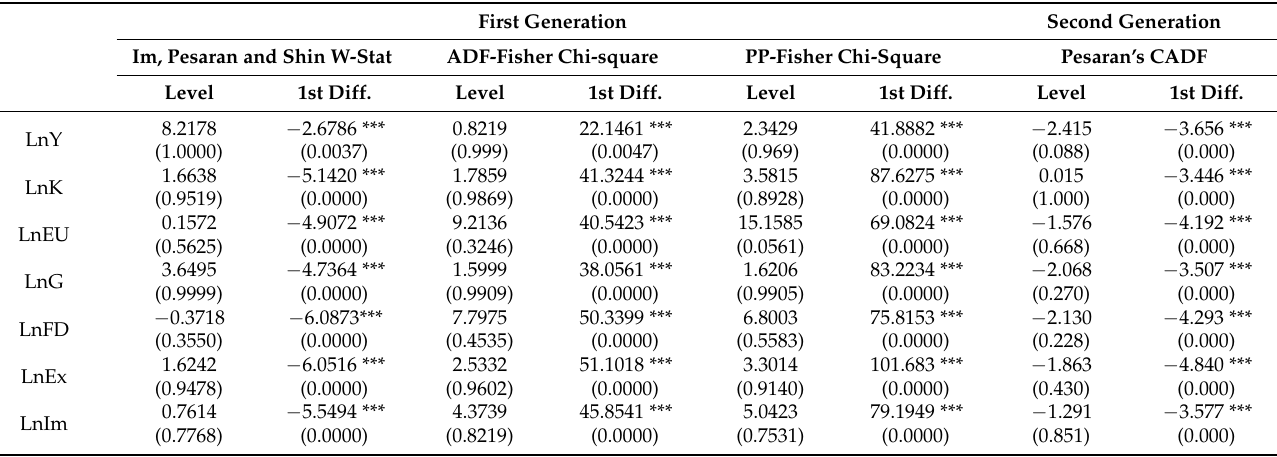
Table 4. The results of Panel Unit root tests.